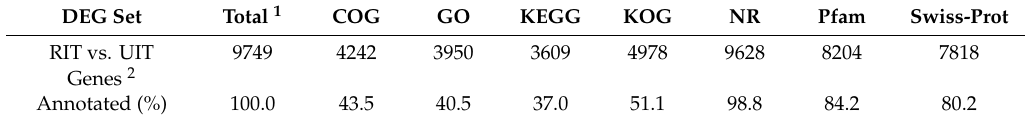
Table 3. Annotation of non-redundant unigenes using queries of public databases.